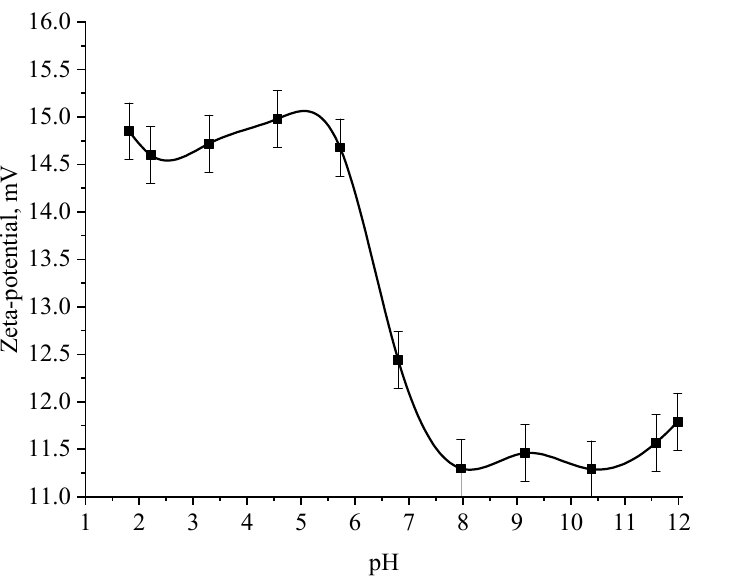
Figure 13. Graph of the dependence of the ζ -potential of Se NPs positive sol on the active acidity pH.